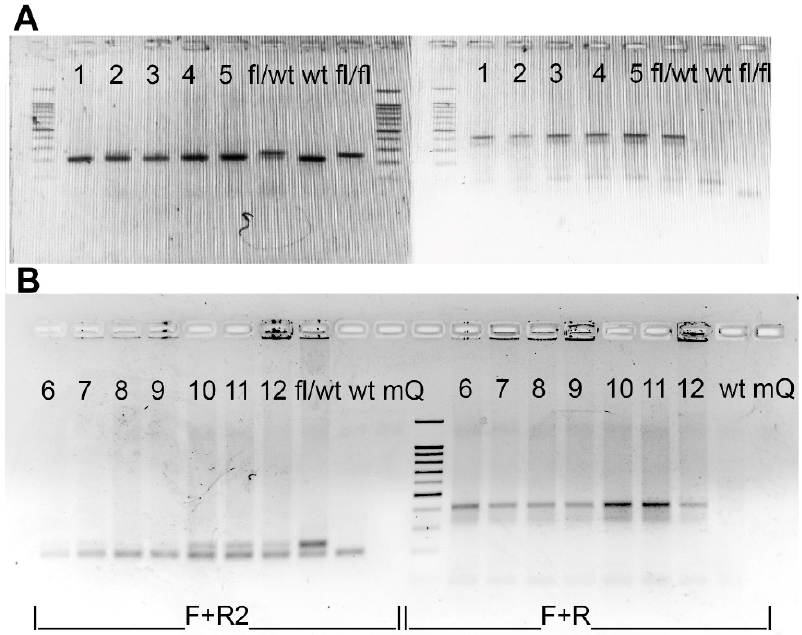
Figure 6. Analysis of exon 2 excision in embryos by DNA electrophoresis. Single 208 bp band without 242 bp band (left sides, “F + R2”) confirmed the presence of wild type allele and complete excision of floxed sequence, while presence of both bands indicates incomplete excision. 414 bp (right sides, “F + R”) confirms presence of edited allele. ( A ) Complete excision of exon 2 after tamoxifen administration starting at 10.5 dpc (lanes 1–5). ( B ) Incomplete excision (lanes 10–12) of exon 2 after tamoxifen administration starting at 17.5 dpc. “fl/wt”—treated heterozygous for a floxed exon mouse sample, “wt”—wildtype mouse, “fl/fl”—untreated homozygous for floxed exon mouse sample, mQ—no template control (milliQ water).